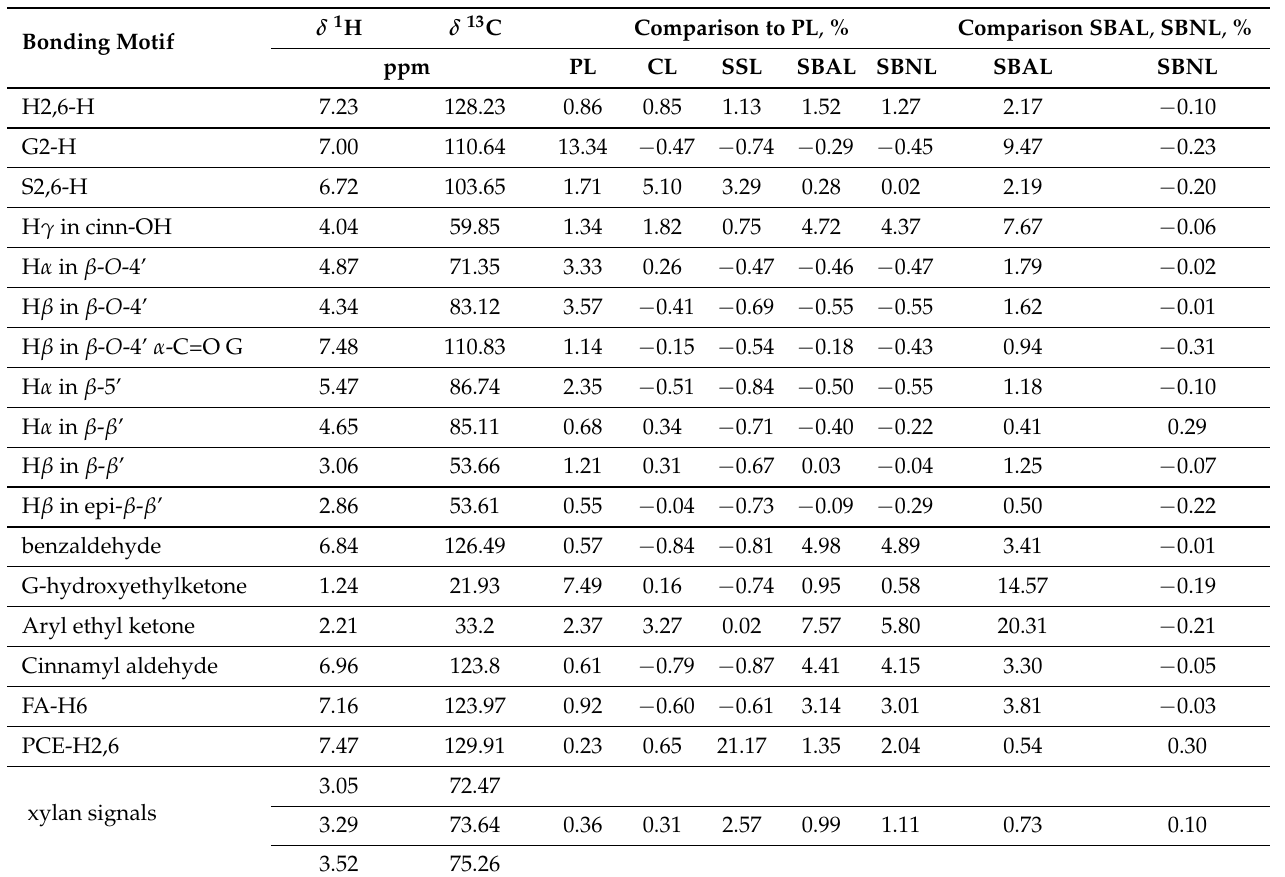
Table 4. Summary of identified structural motifs in the lignins under study based on HSQC-analyses. PL has been set as base for comparison across all samples; SBAL and SBNL compared directly. The abbreviations of lignin fractionated from pine sawdust (PL), cotton stalks (CL), sweet sorghum bagasse (SSL), spruce bark with (SBAL) and without acid addition (SBNL) were